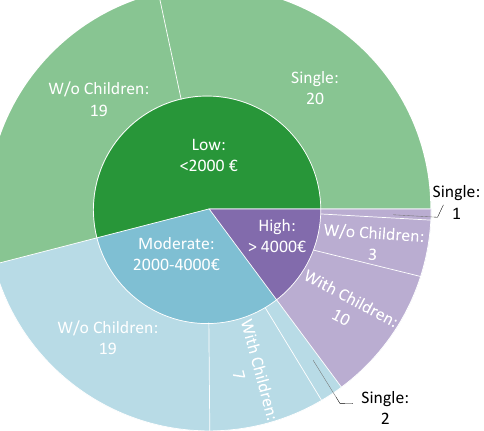
Figure 6. Distribution of mobility groups for this case study.